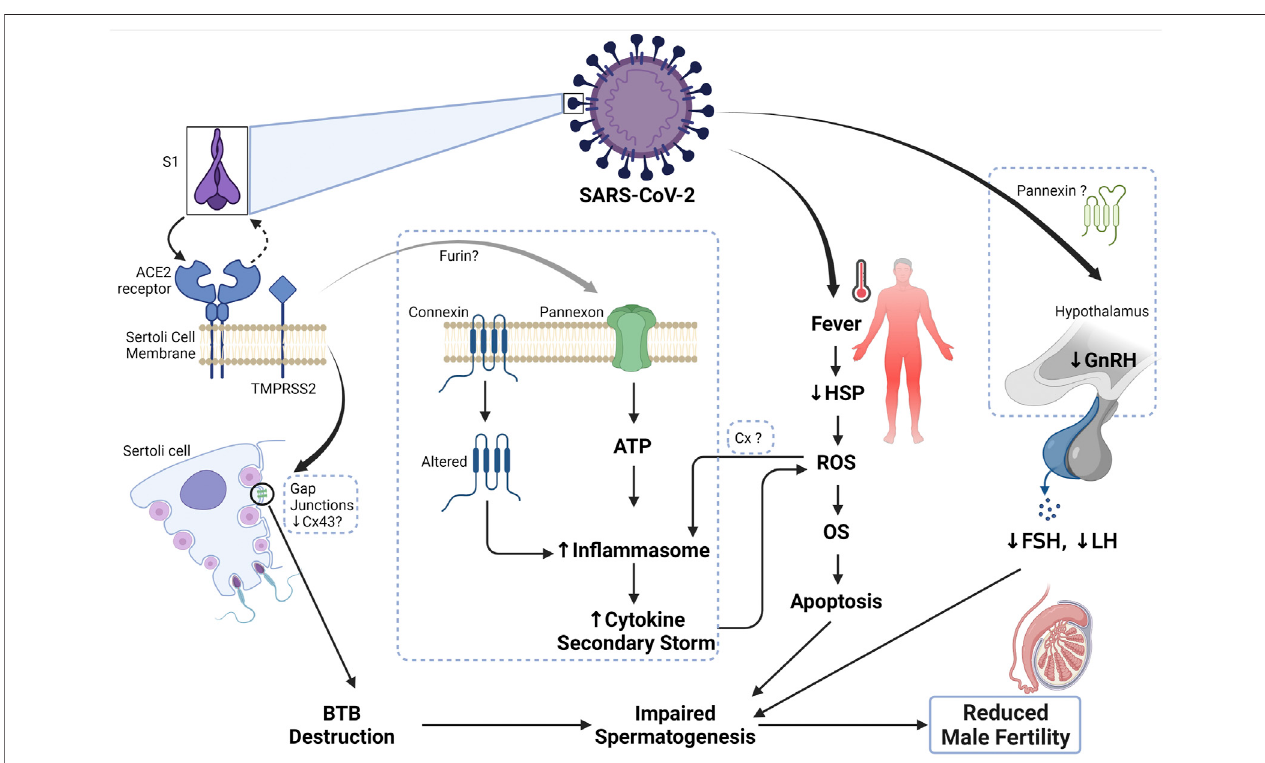
FIGURE 2 | Mechanism of SARS-CoV-2 and male infertility. The S1 subunit of the SARS-CoV-2 binds the ACE2 receptor on the Sertoli cell membrane, which in turn activates TMPRSS2 and cause a conformational change to the complex, thus allowing the entry of the virus. Connexin 43 is abundant on the Sertoli cell membrane and has been shown to play a role in the Sertoli cell ’ s functionality. In the state of inhibition or depletion of Cx43 on Sertoli cells due to infection or apoptosis, spermatogenesis was reported to be completely inhibited. Therefore, upon SARS-CoV-2 entry, there is a decrease in the expression of Cx43 and other junctional proteins, thus disrupting the blood-testis barrier, and subsequently impairing spermatogenesis. Additionally, the binding of SARS-CoV-2 to ACE2 receptor could plausiblycause theopeningofthe pannexin channel, aprocessdependent onfurin(another protease thataidsviral entry), which couldcausetherelease ofATPintothe cell.ExcessiveATPleadstotheformationofin fl ammasomeandthuscytokinesecondarystormensues.Elevatedin fl ammationinturncausesanincreaseintheformation of reactive oxygen species (ROS) and further leads to the development of oxidative stress (OS). Occurrence and sustained OS status causes apoptosis and subsequently impaired spermatogenesis. Persistent fever can also increase the generation of ROS and cause OS, due to the reduction of heatshock proteins (HSP) during viral infection. Since SARS-CoV-2 can cross the blood-brain barrier, upon infection, the function of the hypothalamus is impaired, thus resulting in reduced secretion of gonadotropin-releasing hormone and consequently reducing the generation of luteinizing (LH) and follicle-stimulating hormones (FSH). Altered endocrine control leads to impaired spermatogenesis and ultimately, reduced male